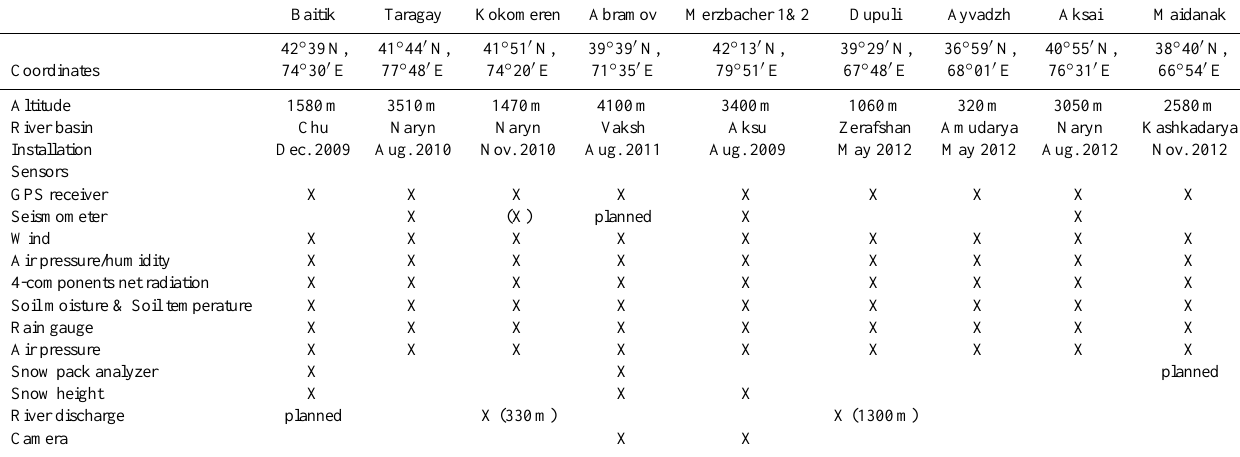
Table 5. Overview about the installed ROMPS and their sensor equipment (status November 2012). The seismometer at Kokomeren is independently installed sharing the VSAT link only. The distance in brackets for the river discharge is the horizontal distance between the main station and the discharge sensor.